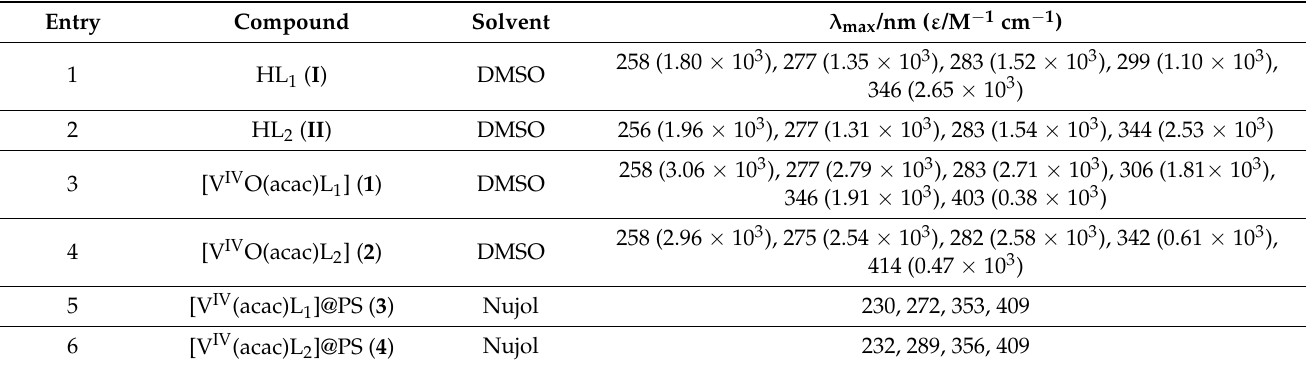
Figure 10. UV-visible spectra of ( a ) HL 1 ( I ) and [V IV (acac)L 1 ] ( 1 ), and ( b ) UV-visible spectra of HL 2 ( II ) and [V IV O(acac)L 2 ] ( 2 ).